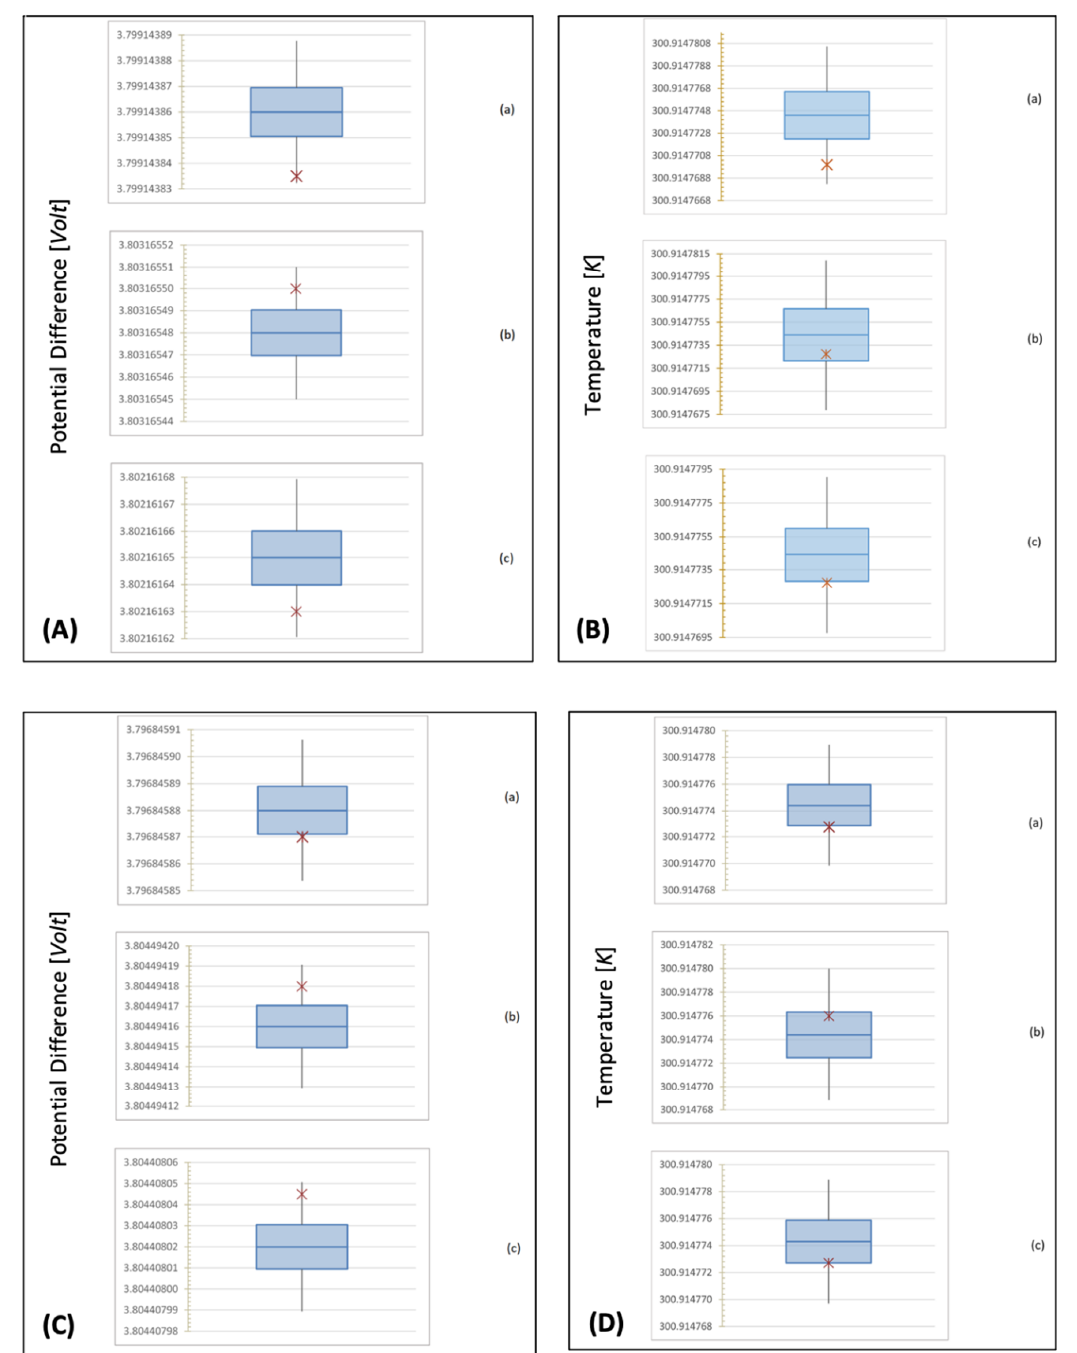
Figure 8. The box plots display the predicted probability distributions of ( A ) potential differences, ( B ) temperature, between plates at three random locations selected in block A in the first simulation group, and ( C ) potential differences, ( D ) temperature at the three locations in block B in the first simulation group. The red “X” marks denote the corresponding results at these locations at the 25th s. using the method in work [16], and they all fall within the 95% prediction confidence interval presented in this paper. The scales are to show potential differences and temperatures as marked (Units: ( A , C ) Volt and ( B , D ) K).